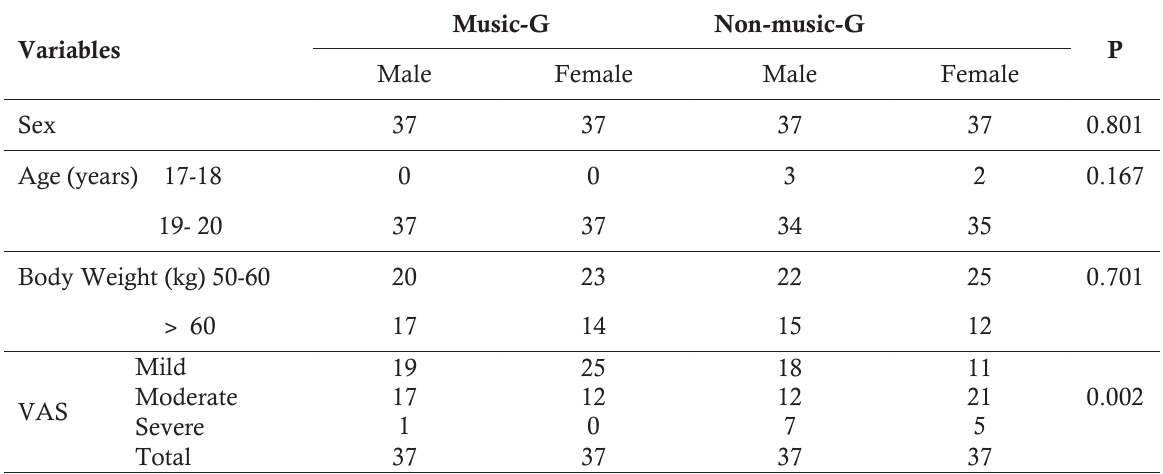
Table 1. Basic characteristics of sample and observation result after listening to Classical Music